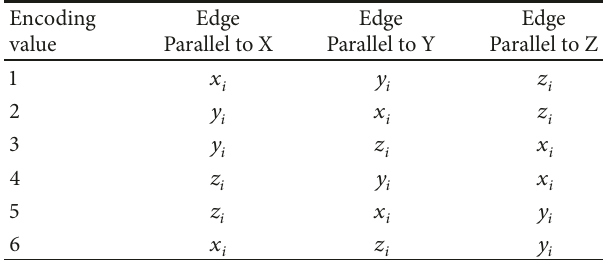
Table 1: Encoding values of placement